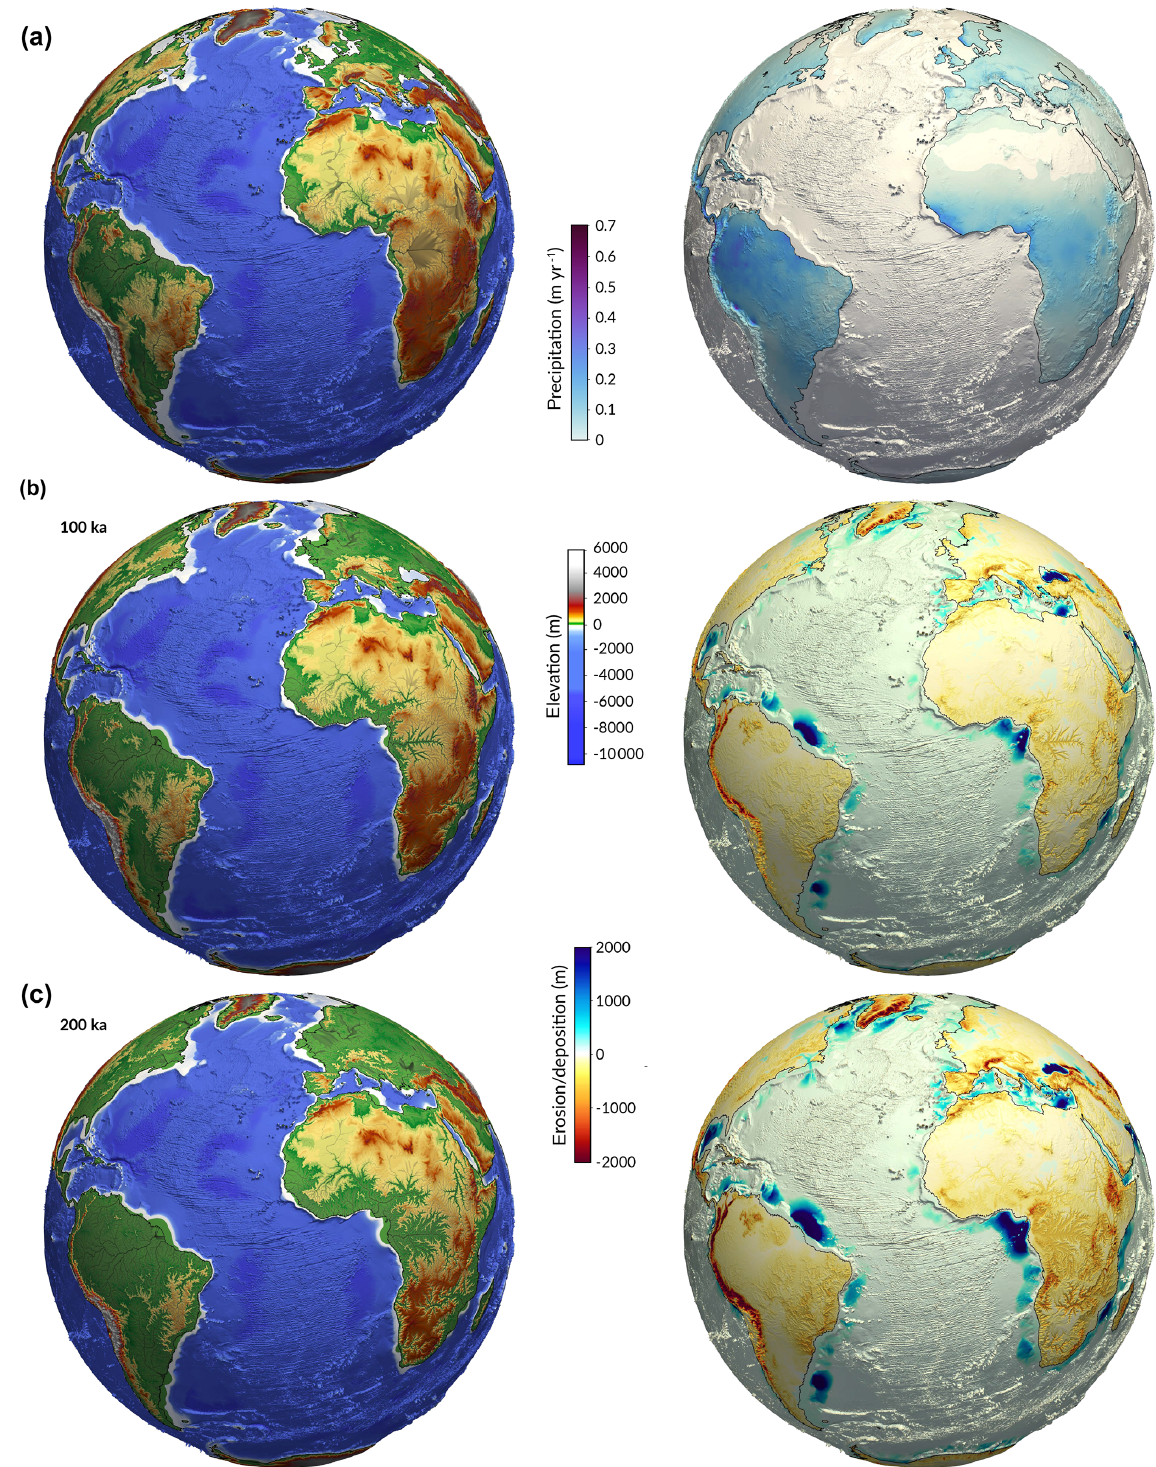
Figure 5. The eSCAPE global-scale experiment of Earth’s morphological evolution over 200000 years. Panel (a) presents the initial elevation based on the ETOPO1 dataset and forcing precipitation obtained from the WorldClim dataset. Panels (b) and (c) show the elevation and cumulative erosion–deposition resulting from the action of rivers and hillslope processes at different time